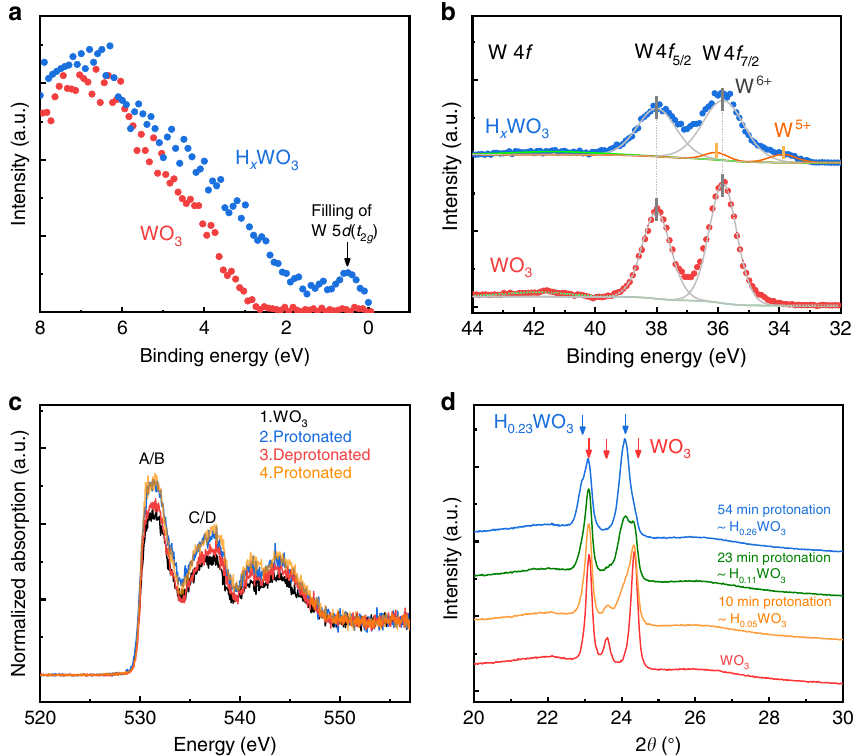
Fig. 4 Electronic and crystallographic structure during protonation to tune the conductance. a Intensity of photoelectron emission vs. binding energy, at the low binding energy region corresponding to the valence band of WO 3 and protonated H x WO 3 , measured by X-ray photoelectron spectroscopy (XPS). b W 4 f photoelectron emission peak, measured by XPS. The oxidation states of WO 3 and protonated H x WO 3 were deduced from the position of the W 4 f 7/2 peak. c X-ray absorption spectra of the oxygen K-edge, upon two cycles of protonation/deprotonation: (1) WO 3 , (2) fi rst cycle protonated H x WO 3 , (3) deprotonated WO 3 , and (4) second cycle protonated H x WO 3 . d Crystal structure change probed by X-ray diffraction pattern with heavy proton intercalation corresponding to the different conduction regimes shown in Fig. with W 6 + 50 . After protonation, a new W 4 f 7/2 component at 33.8 eV was identi fi ed. This lower binding energy corresponds to the reduced W oxidation state of 5 + 51 . Deconvolution of the peaks reveals the ratio between W 5 + and W 6 + to be 1:11.4,